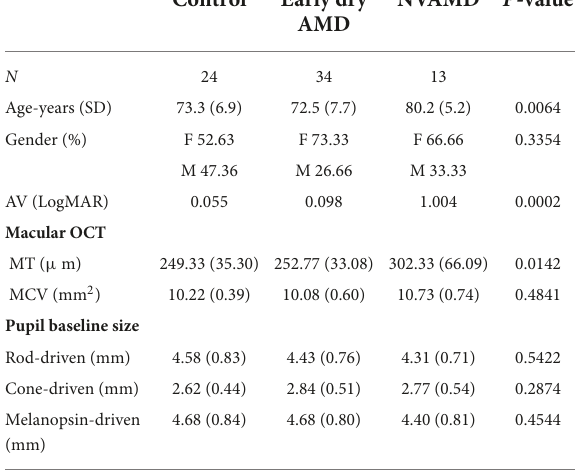
TABLE 1 Demographic data for control, early, and NVAMD